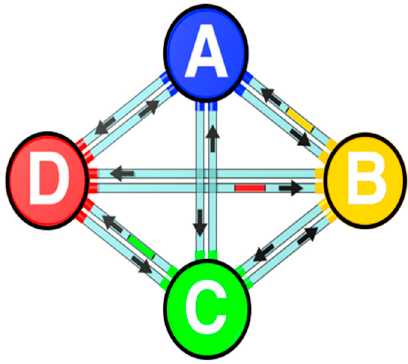
Figure 6. A network of four interconnected processes (A–D) in homeostasis. The reset equilibrium function (REF) returns each process in to its set range. An adjustment in one process may necessitate a compensatory adjustment in one or more of the other interacting processes until equilibrium is reached. Thus, when A stimulates B to lower its activity level, the reduced value in B stimulates C, D, and A.